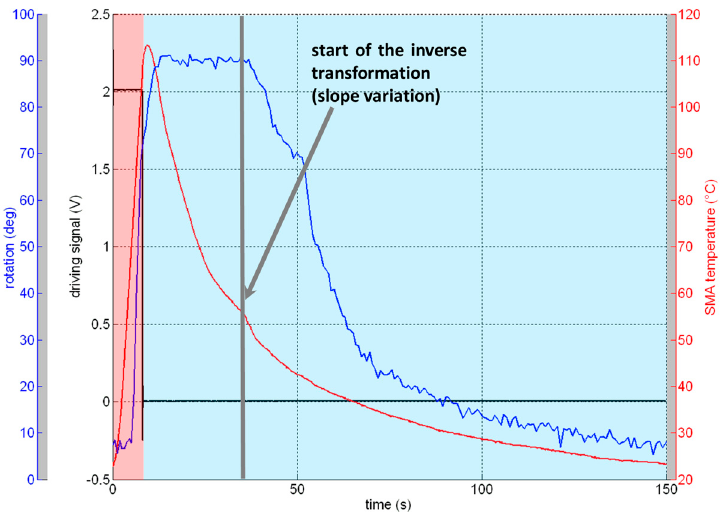
Figure 13. Detail of a single deployment-retraction cycle: activation–heating (red zone), deactivation–